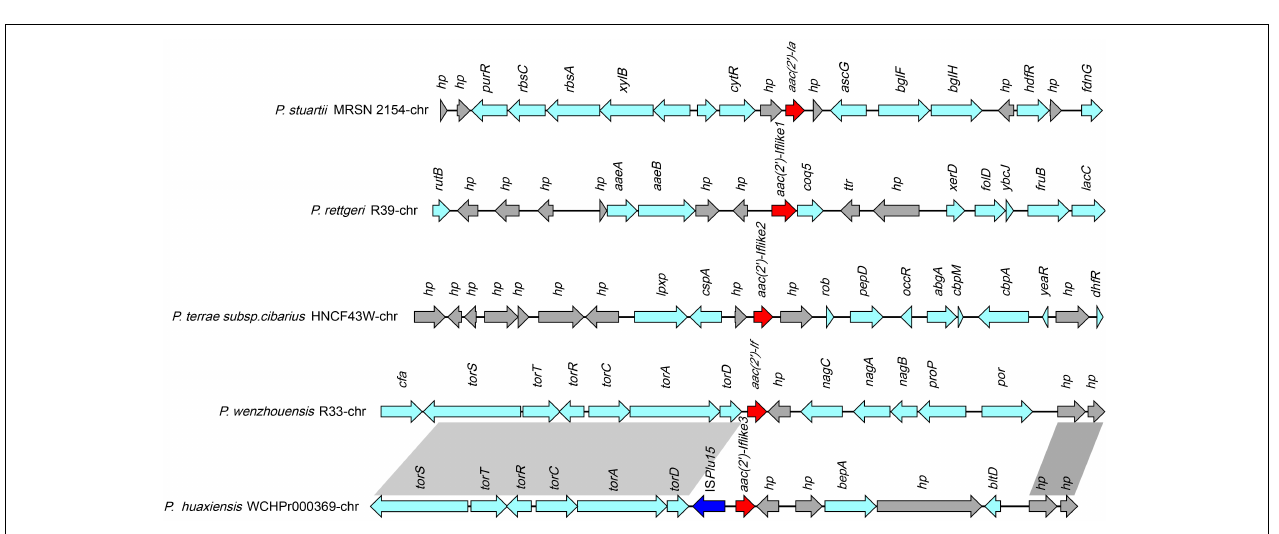
FIGURE 5 | Comparative analysis of the genomic context of the aac(2 (cid:48) )-If gene with similar sequences. Homologous genes are shown in the same colors, and the genes with no homologs are colored gray. The accession numbers of the sequences are as follows: P. stuartii MRSN 2154 (CP003488.1), P. rettgeri